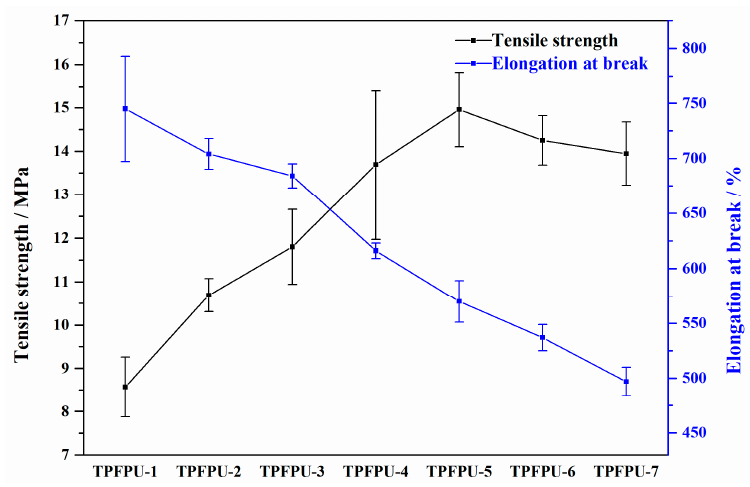
Figure 12. Mechanical properties of the TPFPU films.